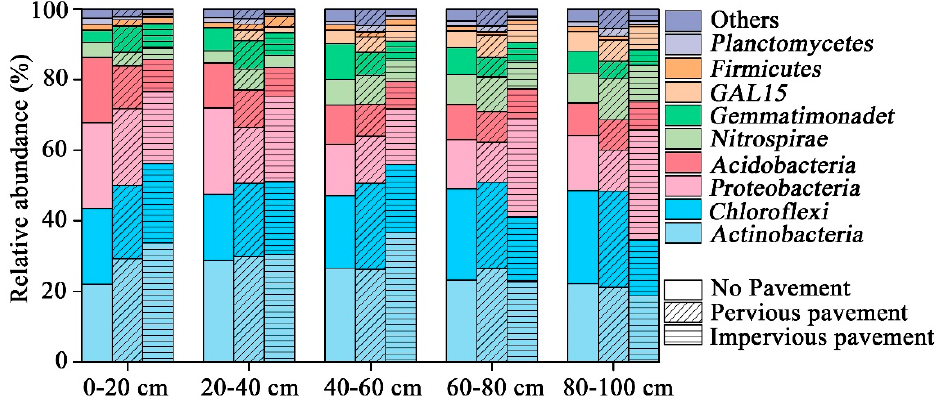
Figure 1. Relative abundance of the dominant bacterial community at the phylum level in samples separated by pavement type category. Relative abundances were found to depend on the average relative number of the bacterial sequences of nine samples from a pavement type. Here, “others” is given with respect to the taxa with a maximum abundance of <0.5% in any sample.